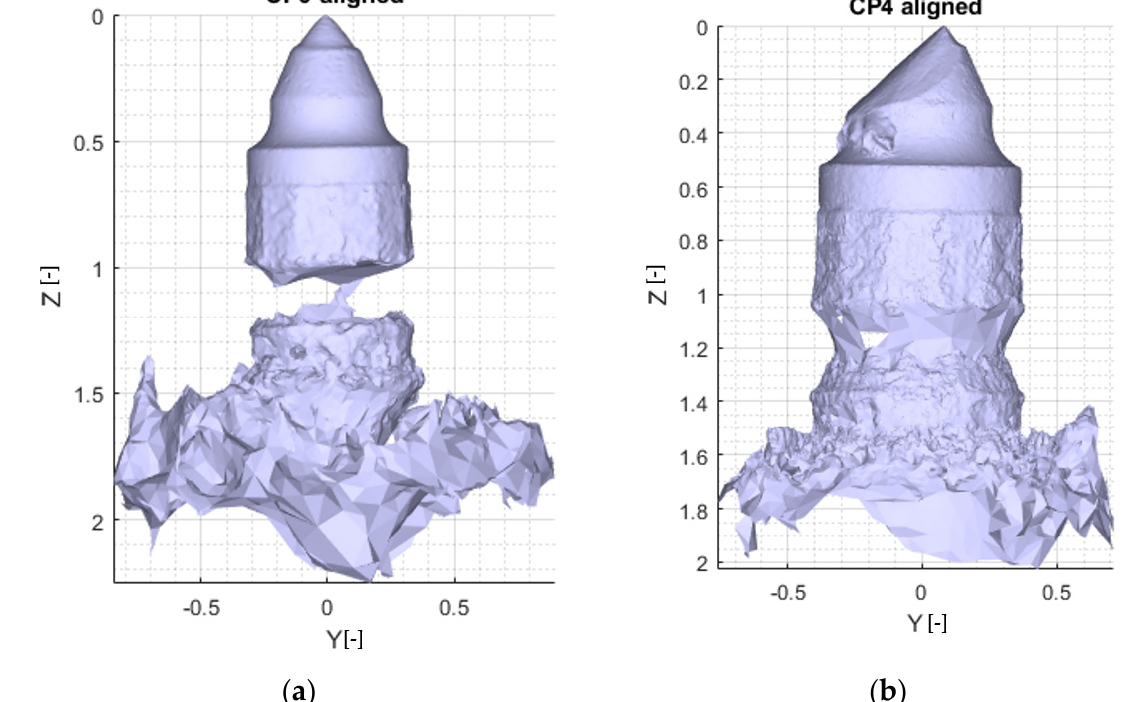
Figure 7. Aligned .stl model of the pick; ( a )—master model, ( b )—pick after exploitation.